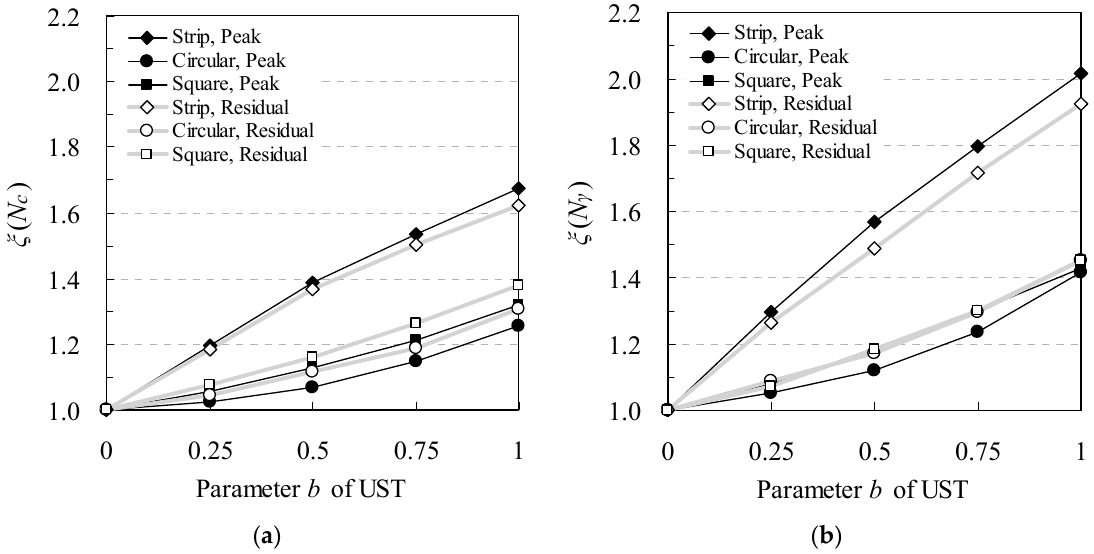
Figure 8. Efficiency factors of intermediate principal stress effect for bearing capacity of strip, circular and square footing: ( a ) N c , ( b ) N γ .